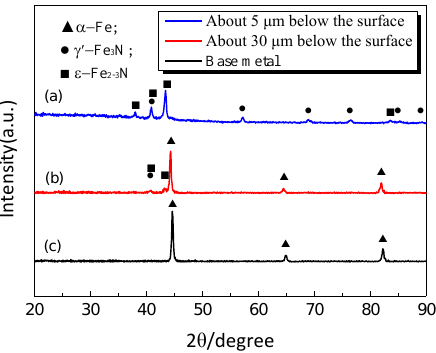
Figure 5. Microstructure observation of nitrided CL60 wheel specimen ( a ) and distribution curve of N element by EDS line scanning ( b ).